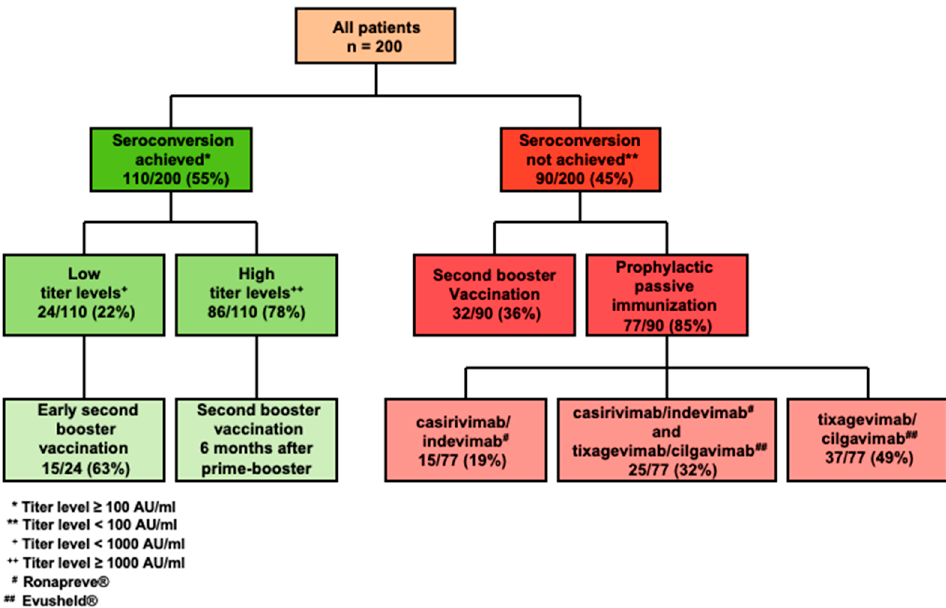
Figure 4. Comprehensive management of patients with hematologic malignancies according to se- rologic response (seroconversion) and anti-spike IgG titer levels after prime-boost